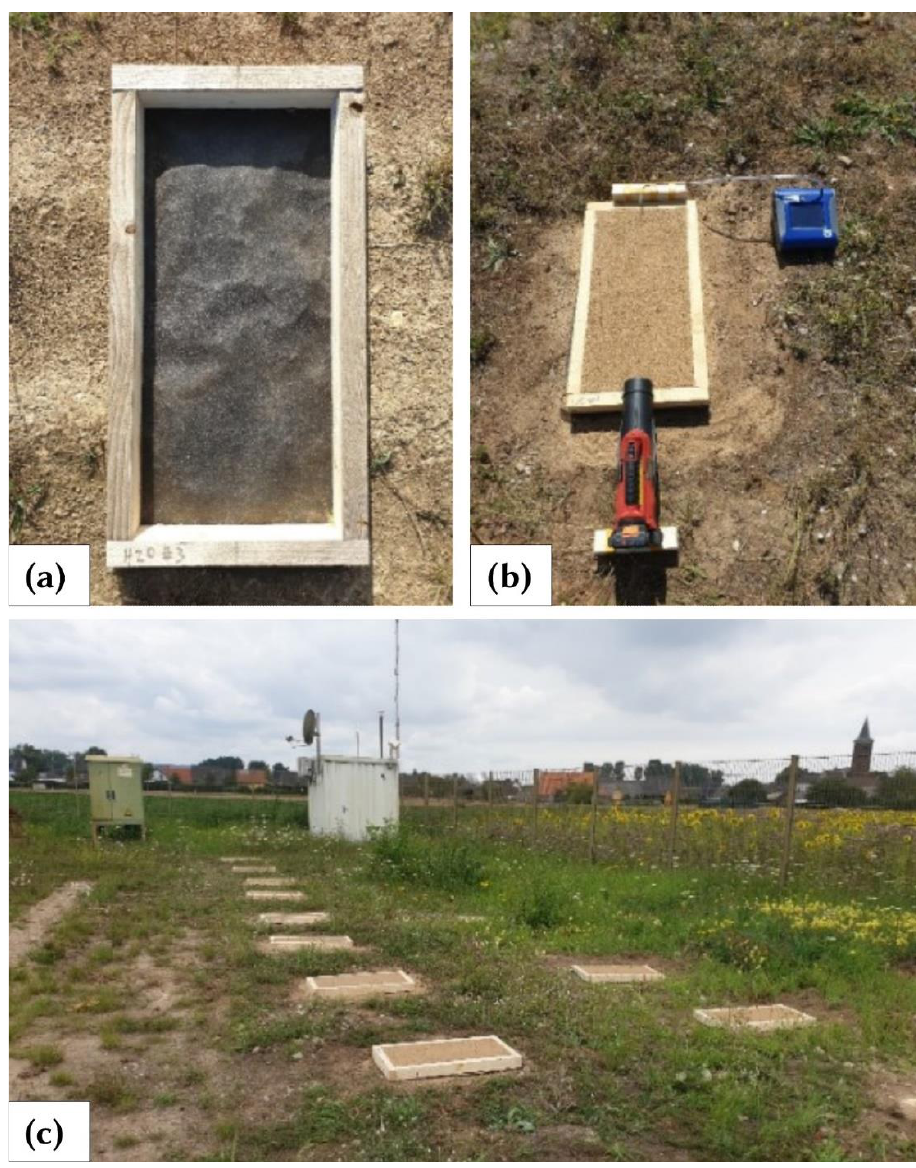
Figure 3. Images of field test site: ( a ) construction design of individual test plot showing wooden frame and geotextile base, ( b ) experimental setup of a single test plot with electric blower, isokinetic sampling probe and dust monitor DustTrak DRX 8533 (TSI, Shoreview, USA), and ( c ) entire test site with installed soil plots and nearby weather station.